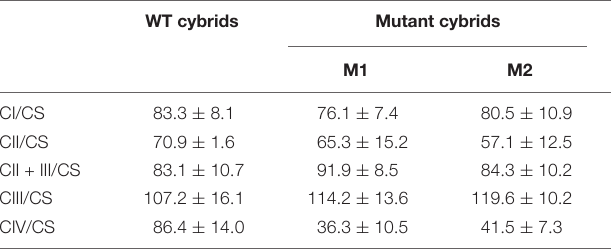
TABLE 2 | MRC enzyme assays in WT and mutant cybrids. WT